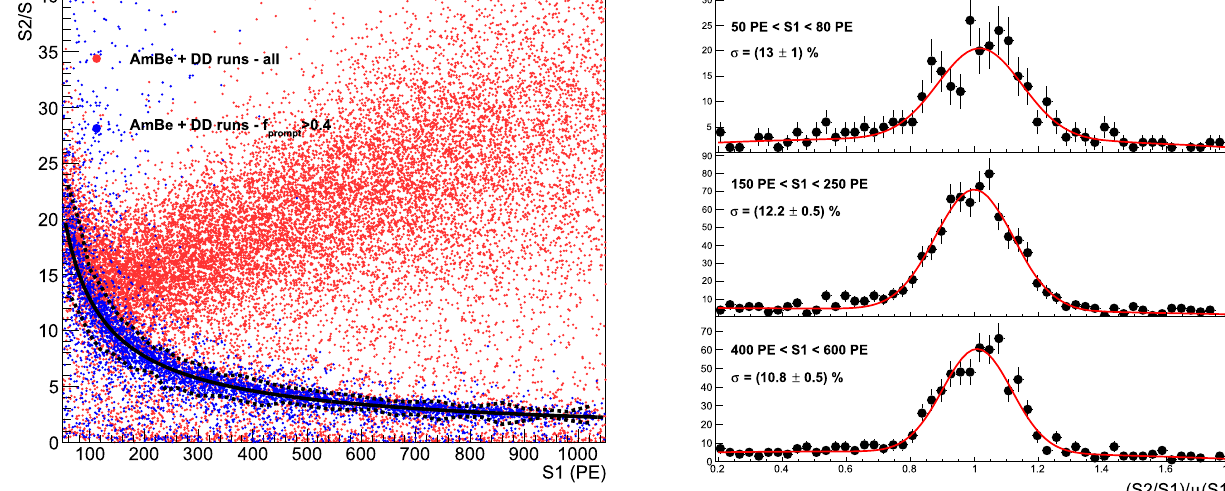
the 90% range is shown by the black dashed curves. Right: Distribution of ( S 2 / S 1 ) μ in three energy ranges: 50–80 PE (top panel), 150–250 PE (middle panel), and 400–600 PE (bottom panel)